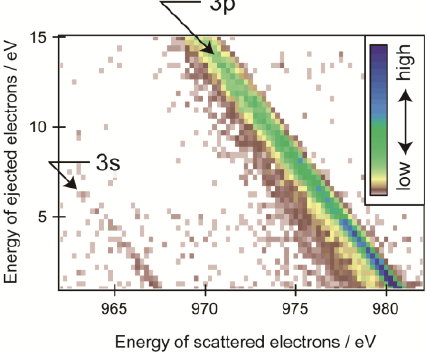
Fig. 2. Energy correlation map between the scattered electrons and the ejected electrons generated through the electron impact ionization of